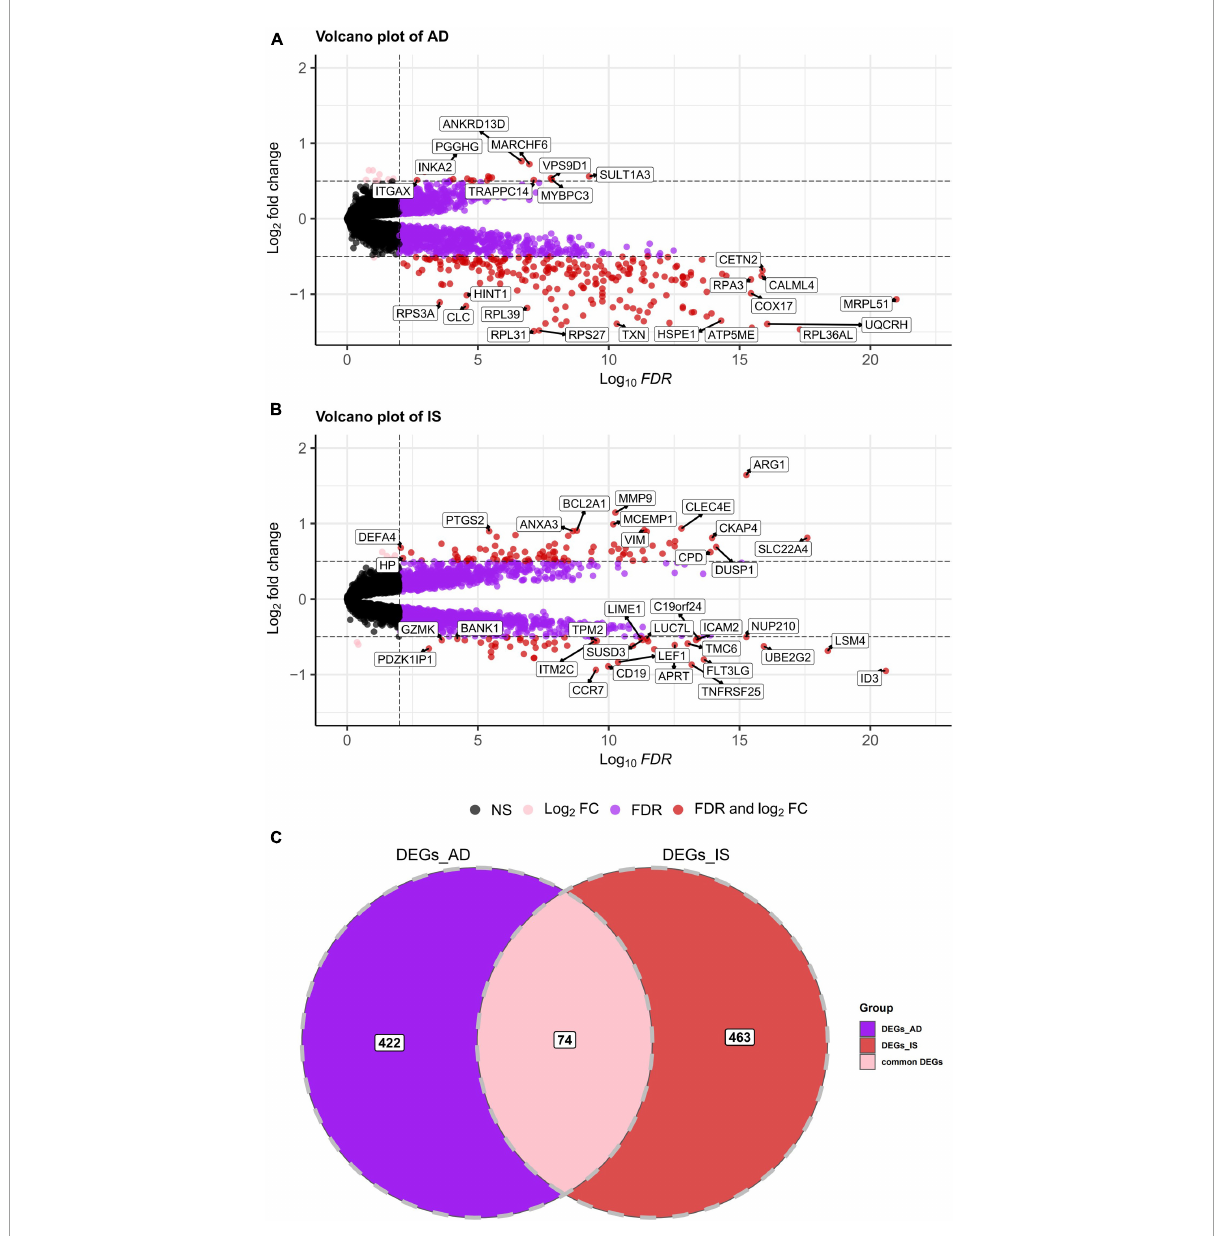
FIGURE2 (A,B) Volcano plot demonstrating an overview of the differentially expressed genes in AD and IS. The threshold in the volcano plot was –lg(adjusted P ) > 2 and |log 2 fold change| > 0.5; red dots indicate significant differentially expressed genes. (C) Venn diagram demonstrates the common DEGs of AD and IS. Red, purple, and pink represent significant DEGs of IS, AD, and both AD and IS,